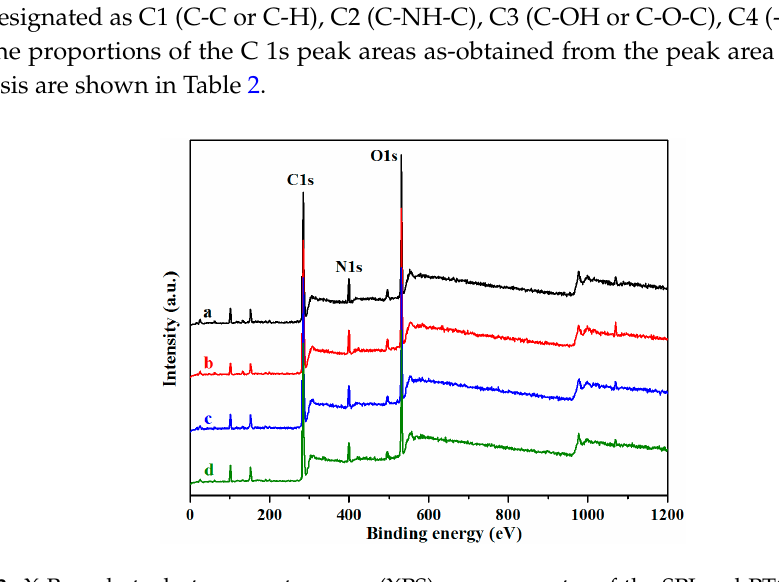
Figure 3. X-Ray photoelectron spectroscopy (XPS) survey spectra of the SPI and PTGE film a ; SPI, PTGE, and HNTs film b ; SPI, PTGE, and CMCS film c ; SPI, PTGE, HNTs, and CMCS film d .